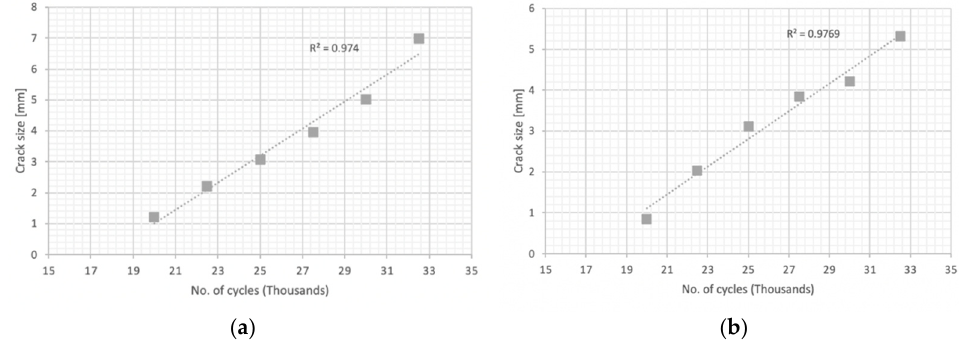
Figure 10. No. of cycles: crack size. ( a ) Bembézar Stringers; ( b ) Bembézar Main Chords .